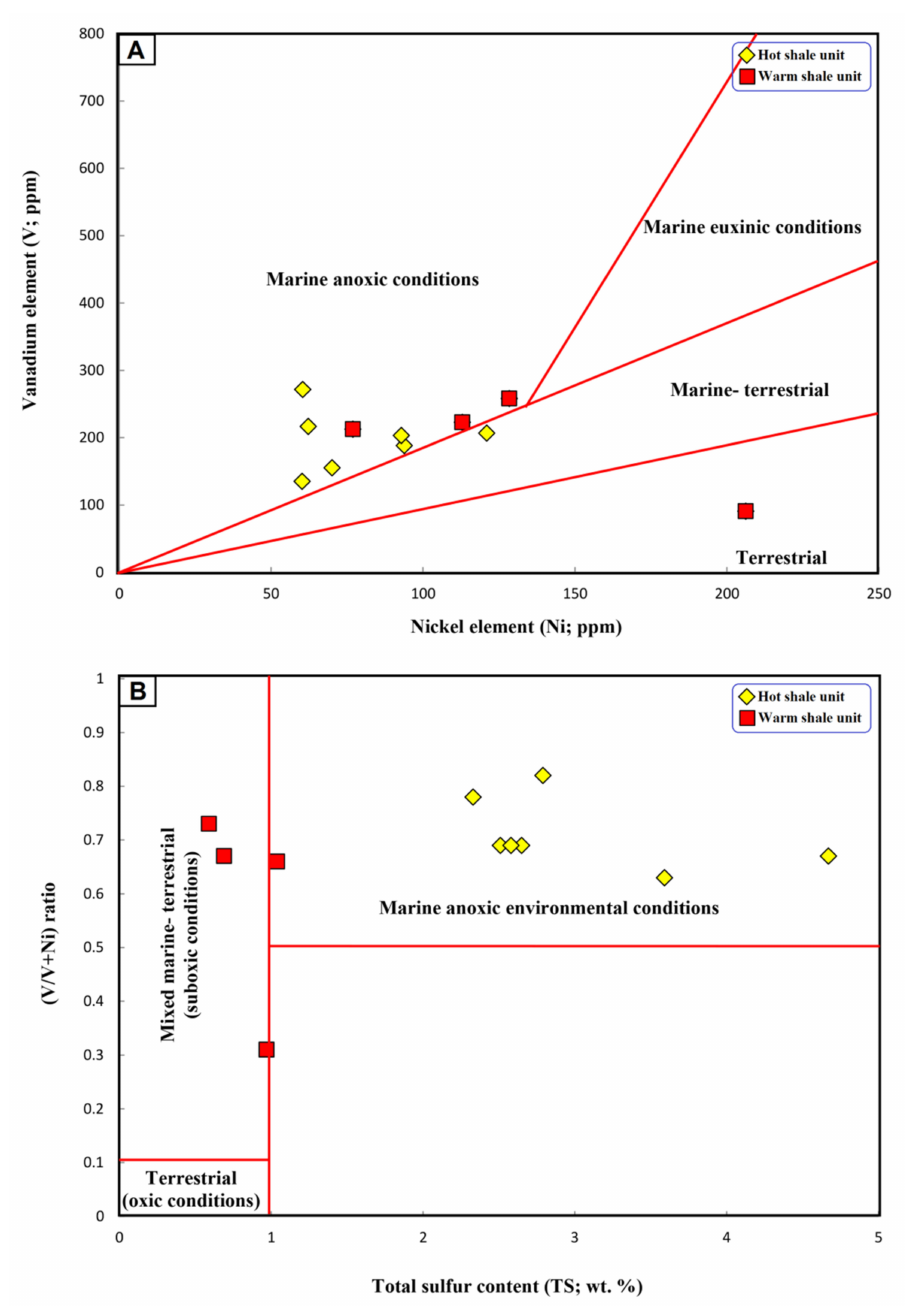
Figure 16. Geochemical correlations of the analyzed organic-rich shale samples of the Qusaiba units, showing ( A ) V and Ni trace elements and ( B ) total sulfur (TS) and V/(V+Ni) ratio. The paleoredox conditions during sedimentation were also assessed using V/Ni ratios [39]. V/Ni ratio of <2 indicates an anoxic environmental condition, while V/Ni ratio of >1 indicates deposition under oxic conditions. In this case, the Qusaiba shale sediments were deposited during anoxic to oxic depositional conditions. The anoxic depositional conditions of most of the samples mainly had a high V/Ni ratio of more than 2 (Table 3), while the other three samples were deposited under relatively oxic (dysoxic-oxic) conditions, with the lowest V/Ni ratio between 0.44 and 1.97 (Table 3). This interpretation of the anoxic to oxic depositional conditions is confirmed from the relationship between total sulfur (TS) content and values of the V/V+Ni ratio (Figure